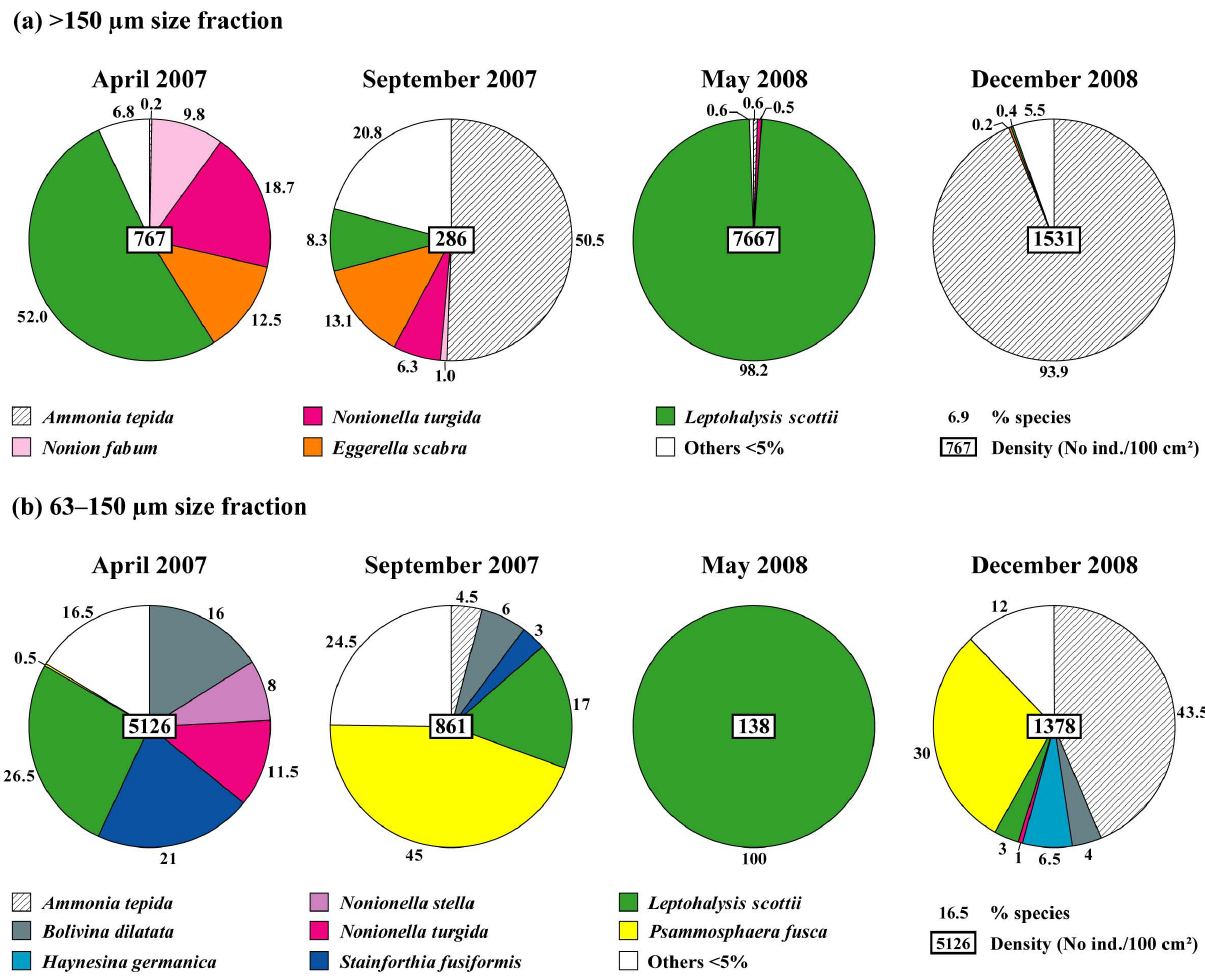
Fig. 6. Relative abundances of the major species in the > 150µm (a) and the 63–150µm size fractions (b) at Station A for the four sampling